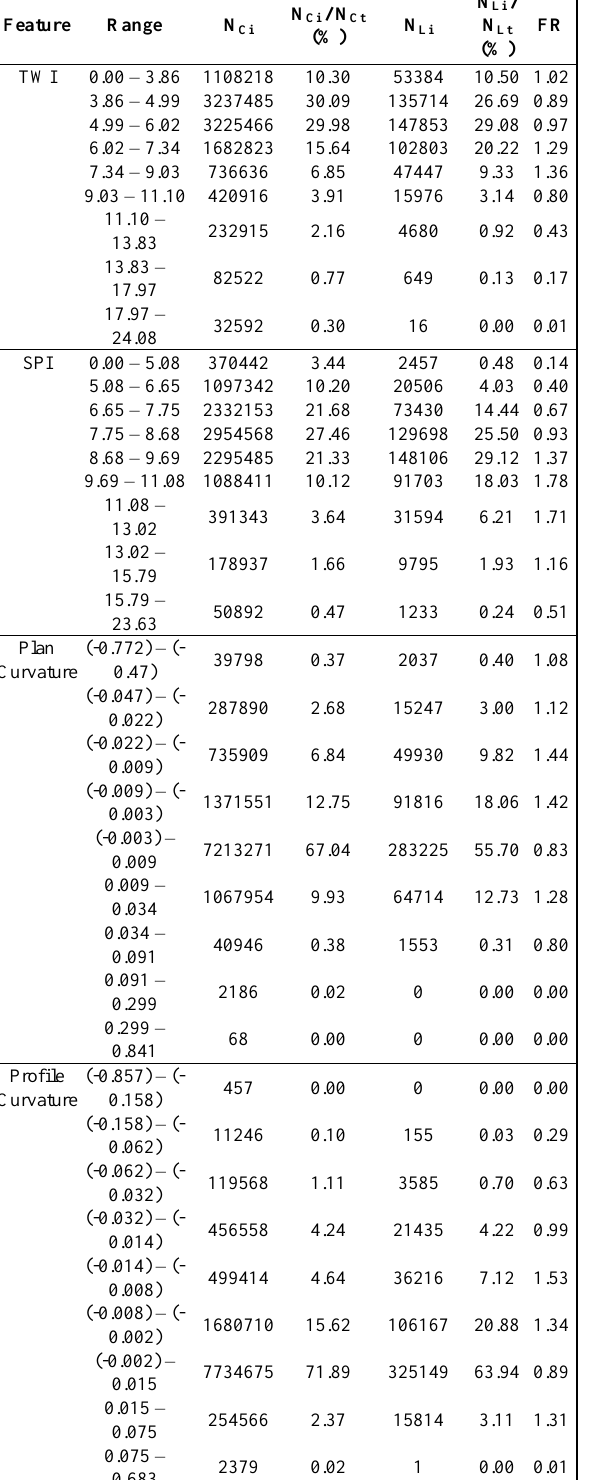
Table A2 . FR statistics Malatya part (TWI, SPI, plan and profile curvatures).